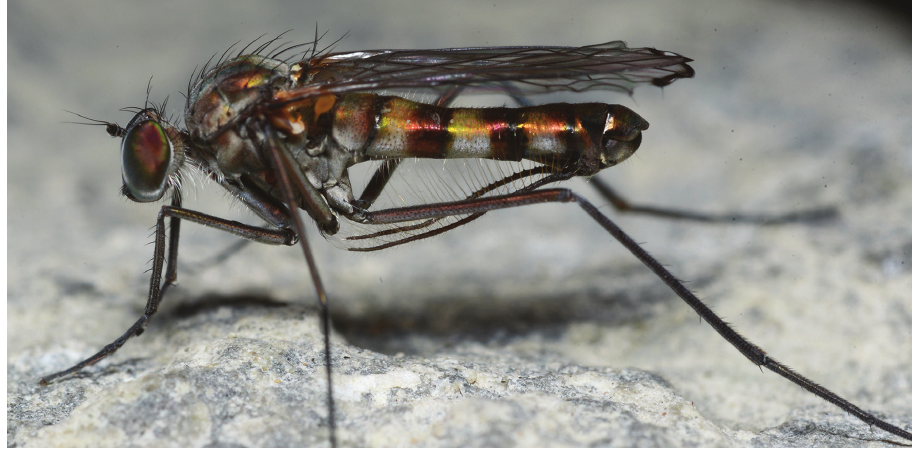
Figure 8. Habitus photograph of male Liancalus hydrophilus Aldrich taken at a waterfall in Utah County, Utah, N39.95963°, W111.2678°, on 13 September 2013. Note long cerci with nearly uniform row of long yellow setae. Photo taken by C. Riley